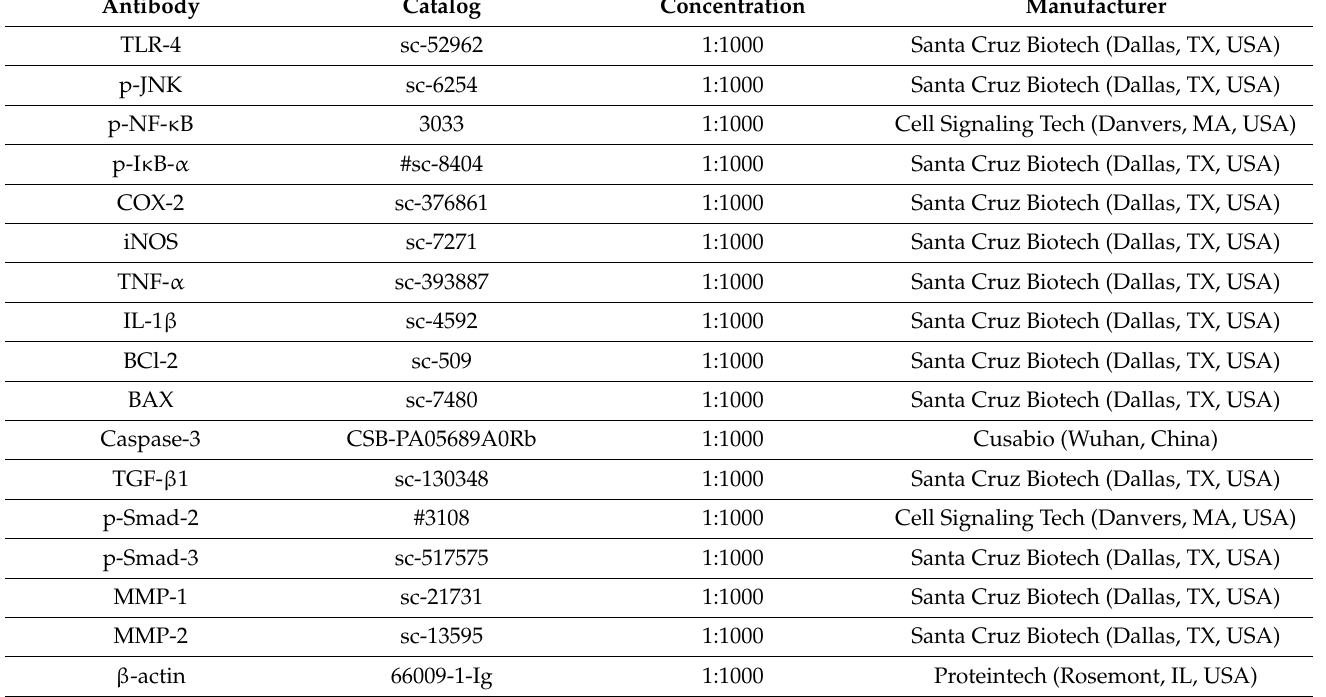
Table 1. List of primary antibody information used in this